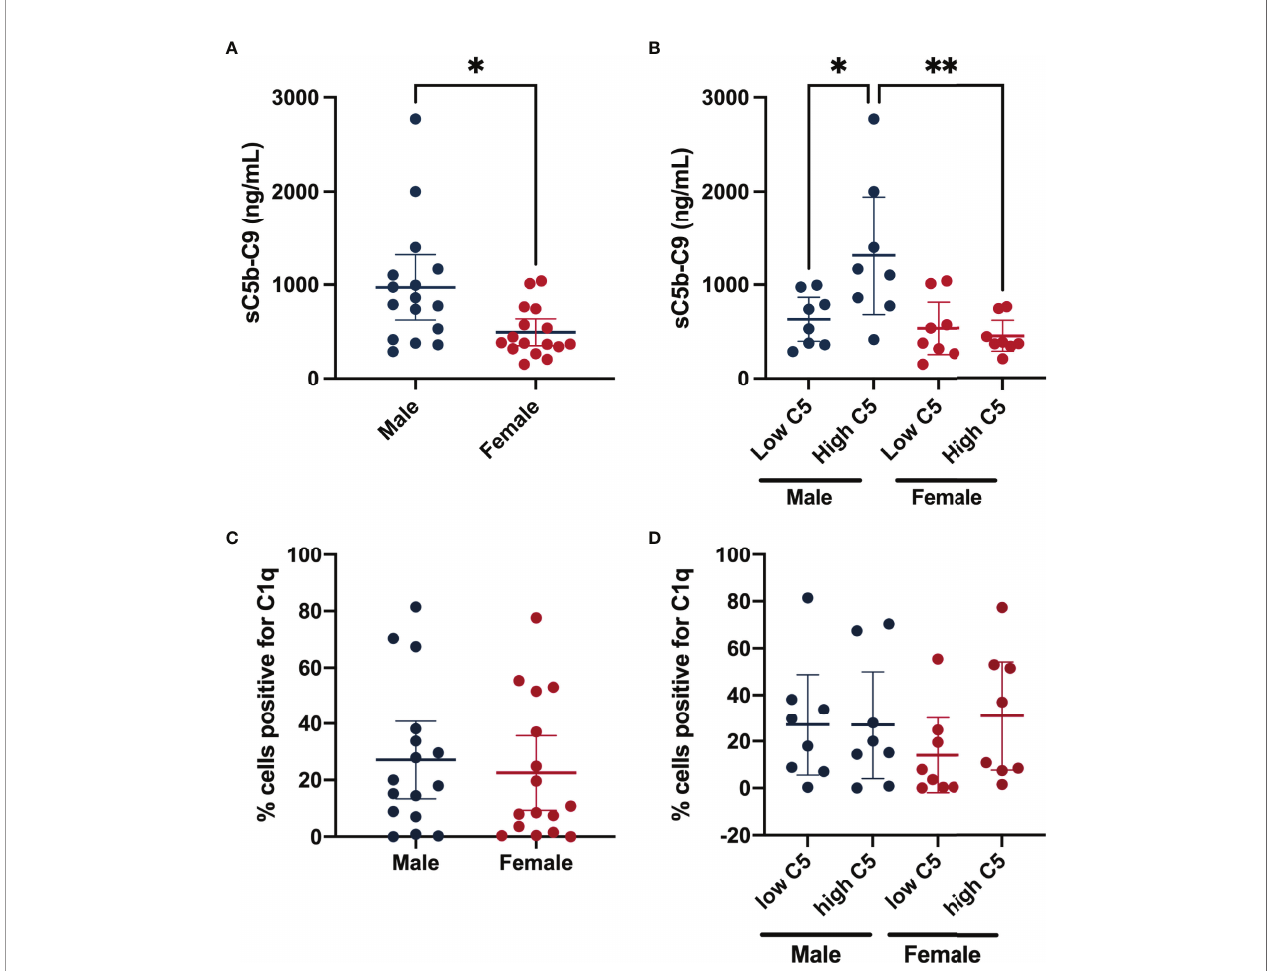
FIGURE 3 | Synovial fl uid terminal complement complex sC5b-C9 levels and synovial lining C1q grouped by sex and synovial fl uid C5 quartile. Data shown are mean sC5b-C9 concentrations (ng/mL) ± 95% CIs for (A) Male (n=16) and Female (n=16). (B) Represents sub-groups of males with low synovial fl uid C5 concentrations (n= 8), males with high synovial fl uid C5 concentrations (n= 8), females with low synovial fl uid C5 concentrations (n= 8), and females with high synovial fl uid C5 concentrations (n= 8). (C) Shows mean percent positive synovial lining cells for C1q ± 95% CIs for males (n=16) and females (n=16). (D) Shows the percent positive synovial lining cells for C1q of patients from the highest and lowest quartiles of synovial fl uid C5 levels for both sexes. *P-value <0.05; **P-value <0.005 for between-group comparisons of synovial fl uid sC5b-C9